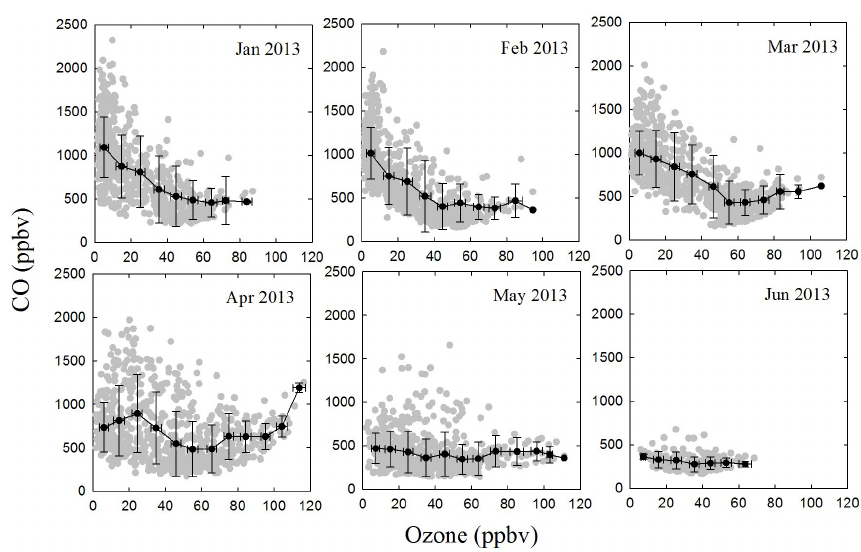
Figure 9. Relation between ozone and CO from January 2013 to June 2013 at Bode. Grey dots are hourly average data and black filled dots are 10ppbv binned data averaged with respect to ozone. The spread around the mean value is 1 σ .